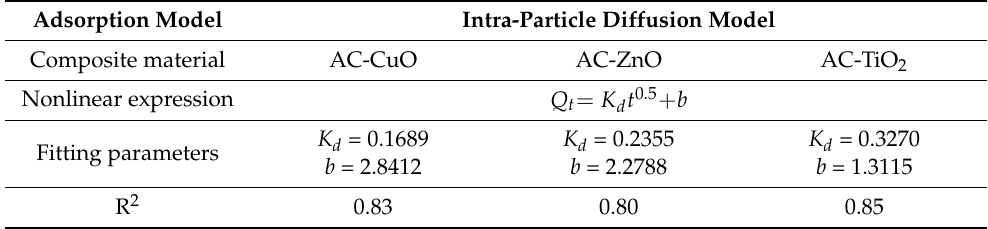
Table 5. Summary of correlation coefficients for intraparticle diffusion model fits.